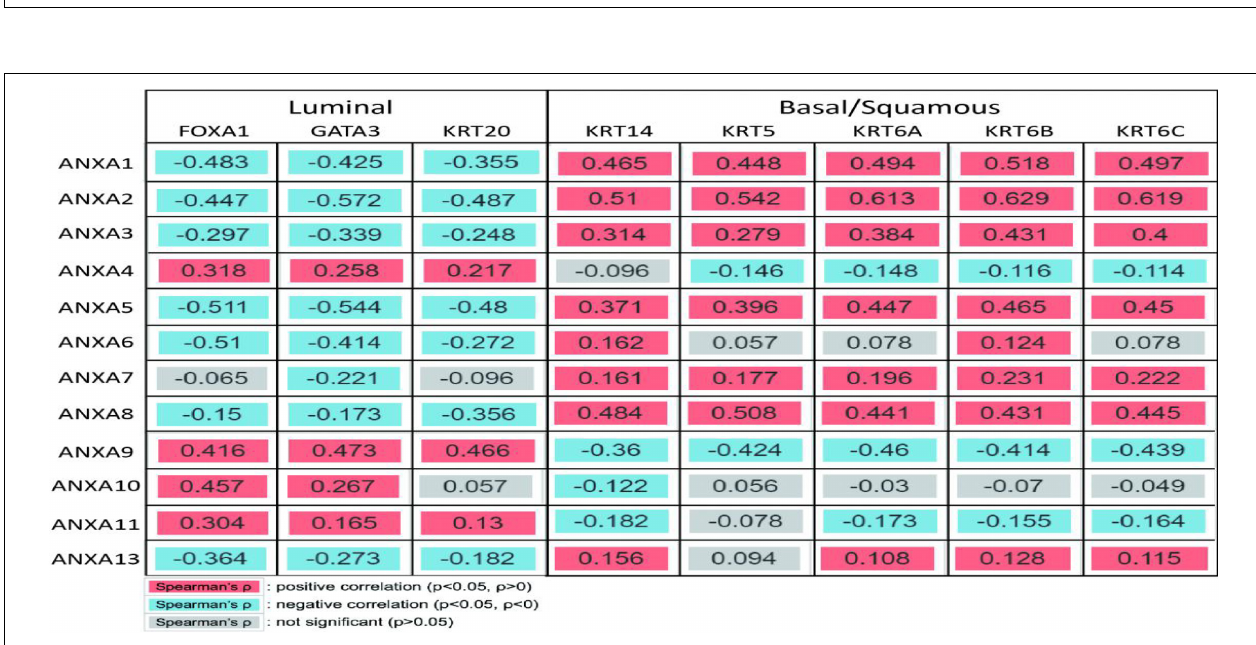
FIGURE 6 | Correlation between the mRNA expression of different ANXA members and histological subtypes of MIBC patients in UALCAN database. The mRNA expression of ANXA family members in normal individuals or in MIBC patients in two histological subtypes (A–L) . (* p < 0.05; ** p < 0.01; *** p < 0.001).